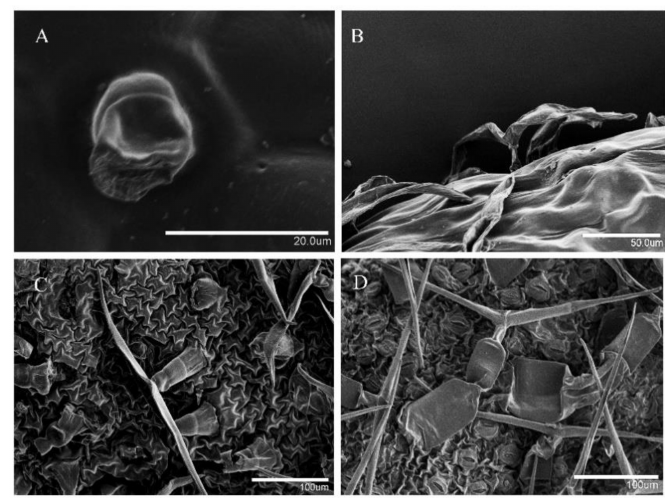
Figure 5. Micrograph observation of the leaf trichomes on the surface of leaves by SEM. ( A ) The capitate trichomes of O. taihangensis , and ( B – D ) the T-shaped non-glandular trichomes of O. taihangensis , C. vestitum, and C. indicum , respectively.